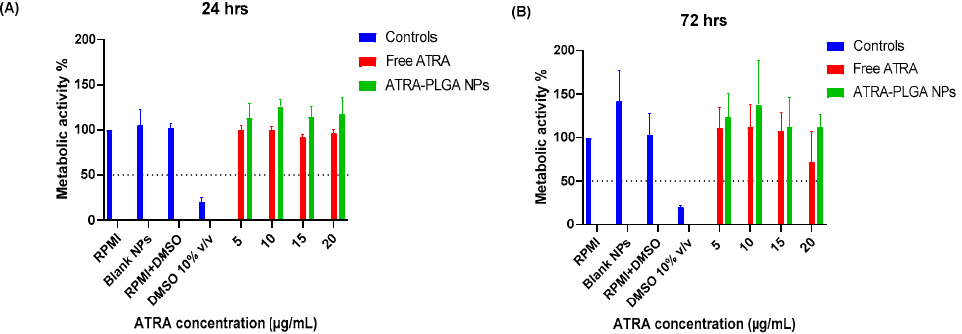
Figure 6. ATRA treatment effect on cell viability as determined by MTS assay. MTS assay was performed at ( A ) 24 and ( B ) 72 h in the absence of H37Ra, and post-treatment of THP-1 cells with ATRA solution in DMSO and ATRA-PLGA NPs (5, 10, 15, 20 μ g/mL of ATRA). RPMI and DMSO 10% v/v groups were utilized as the negative and positive controls, respectively. Results were plotted as (%) metabolic activity relative to RPMI group. Data shown as mean ± SD (n = 3). Statistical analysis was conducted using two-way ANOVA with Tukey’s post-hoc test.